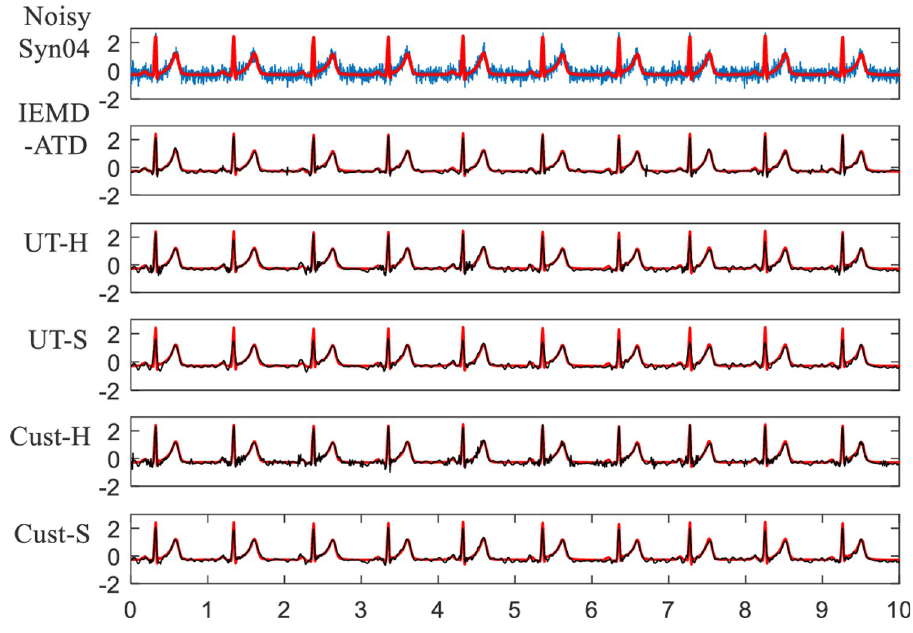
Fig 11. Waveforms of denoised ECG for Syn04 with WN at 5 dB in the 5 denoising methods. SNR improvements of the 5 denoising methods for 6 synthetic ECGs (Syn00-Syn05) are